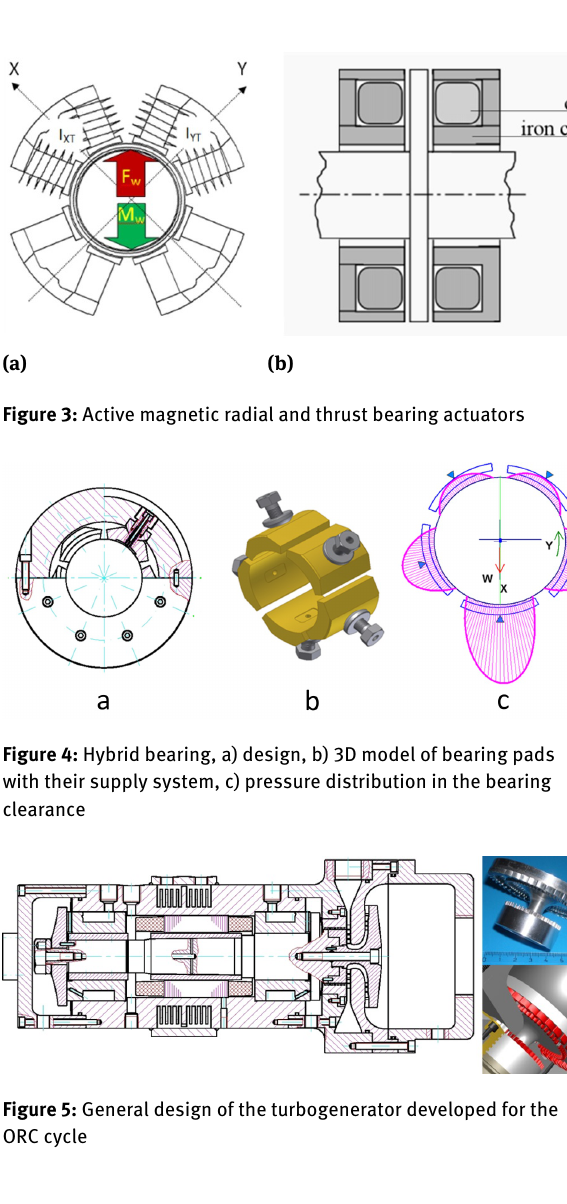
sultant force F is acting along the vertical axis, balancing W the shaft weight M W